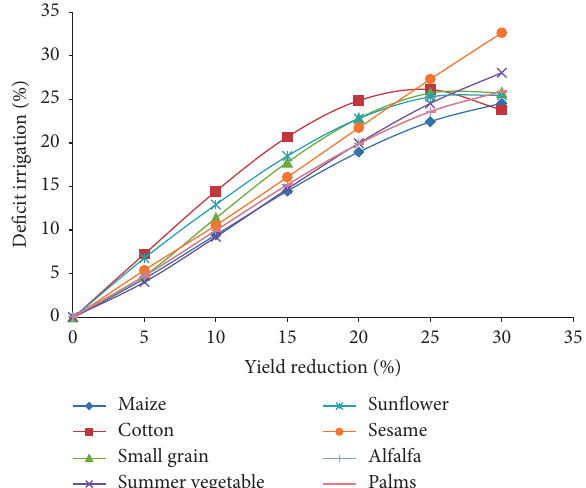
Figure 4: Deficit irrigation against yield reduction for eight crops in medium